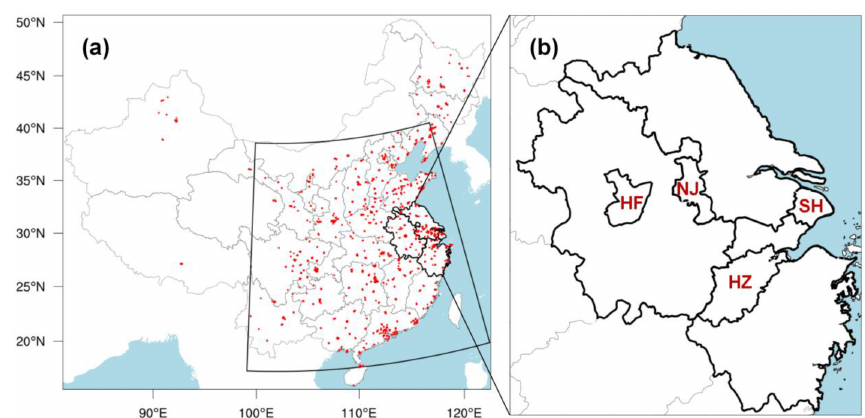
Figure 1. (a) The model domain. Red dots denote the ground-level PM 2 . 5 measurements, which, within the fan-shaped quadrilateral, are used to constrain the model predictions. (b) Black lines outline the boundaries of the Yangtze River Delta (YRD), as well as the four major cities considered (i.e., SH: Shanghai; HZ: Hangzhou; NJ: Nanjing; HF: